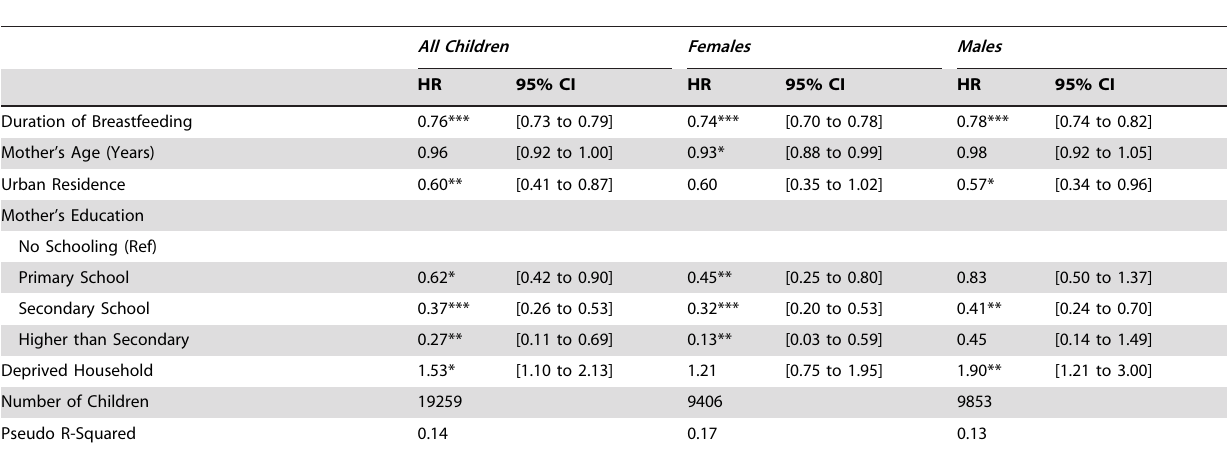
Table 4. Hazard of mortality and duration (in months) of breastfeeding by gender, children aged 0–59 months,